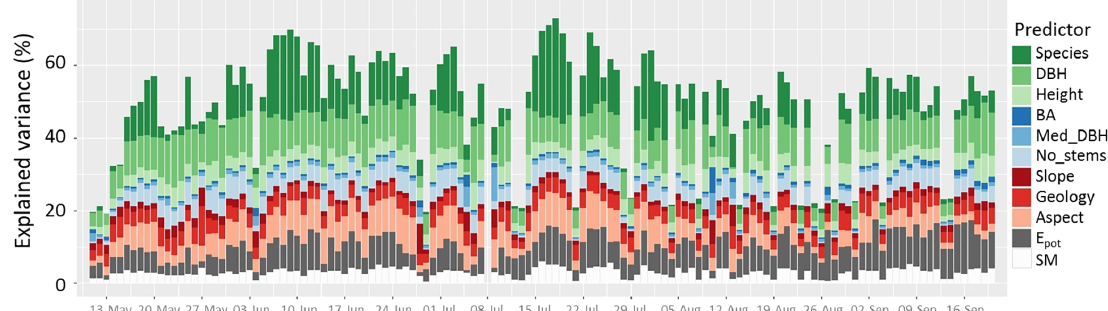
Figure 6. Proportion of variance explained by the different predictors in the daily linear models of spatial sap velocity patterns: 132 daily models from 61 trees at 24 sites.